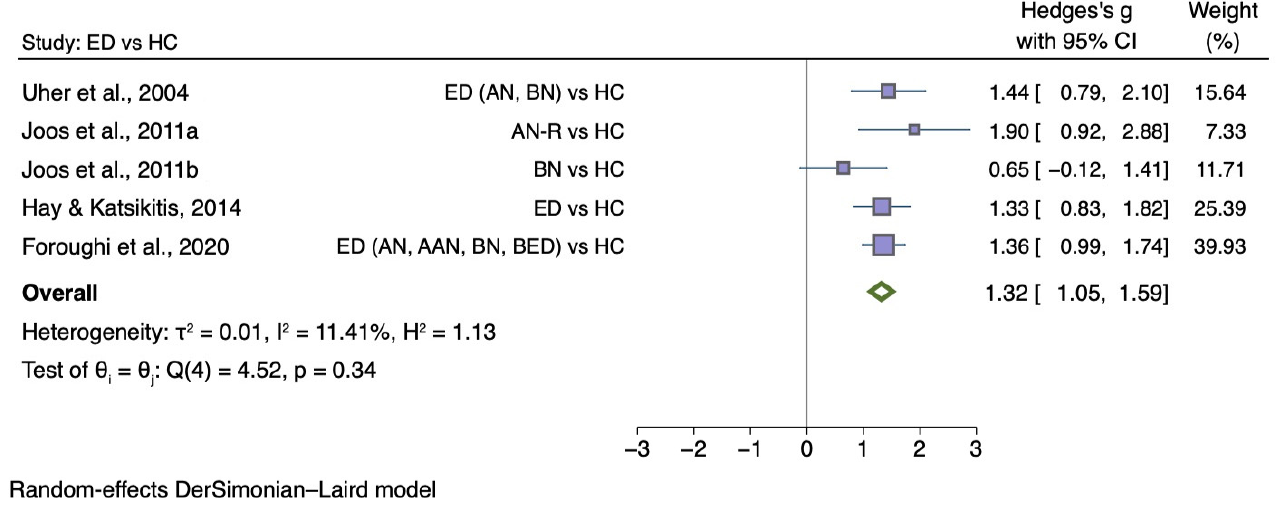
Figure 2. Forest plot of Hedges’ g in disgust elicited by food images between ED participants and HCs from n = 5 studies; CI: confidence interval. Refs. [45,46,49,50,52].